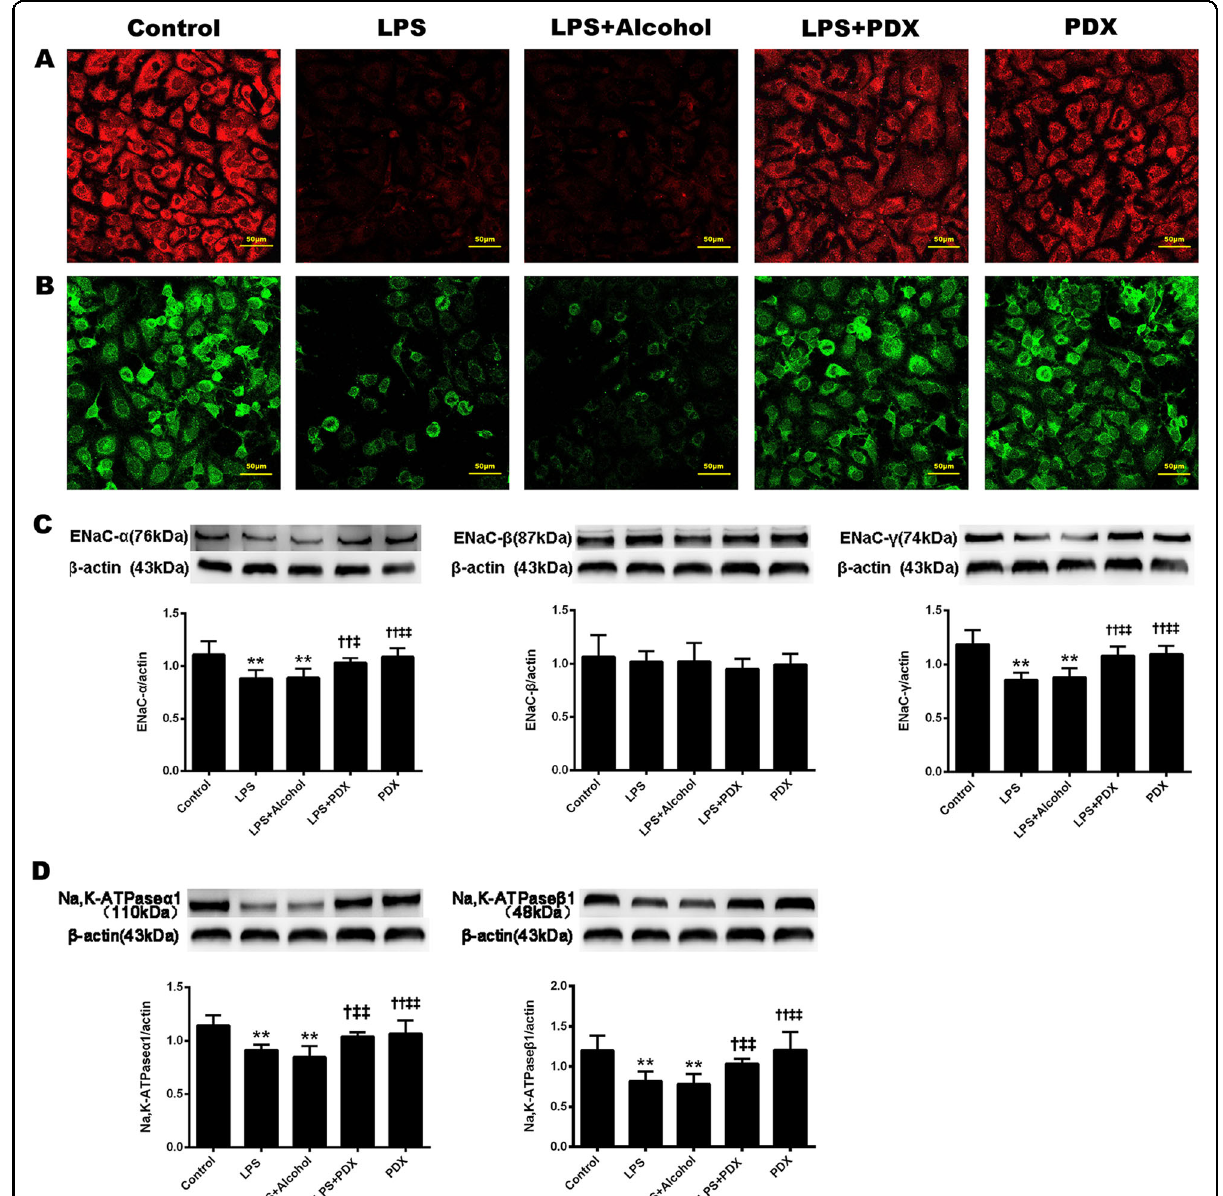
Fig. 6 Protectin DX promoted sodium channel expression in primary rat ATII cells stimulated with LPS. Rat primary ATII cells were treated with protectin DX (3.605 × 10 − 3 mg/l) in the presence or absence of LPS (1 µg/ml) for 6 h. After incubation, the cells were harvested and sonicated. Sodium channel α ( a ) and Na, K-ATPase α 1 ( b ) subunit protein expression levels in the cell lysates were detected by confocal laser-scanning microscopy using a speci fi c Abs (original magni fi cation ×400). In addition, sodium channel α , β , and γ subunit ( c ) and Na, K-ATPase α 1 and β 1 subunit ( d ) protein expression levels in the cell lysates were detected by western blotting. The data are presented as the mean ± SD. n = 8. PDX protectin DX. Alcohol was the solvent for protectin DX. ** p < 0.01 versus the control group; † p < 0.05, †† p < 0.01 versus the LPS group; ‡ p < 0.05, ‡‡ p < 0.01 versus the LPS + alcohol